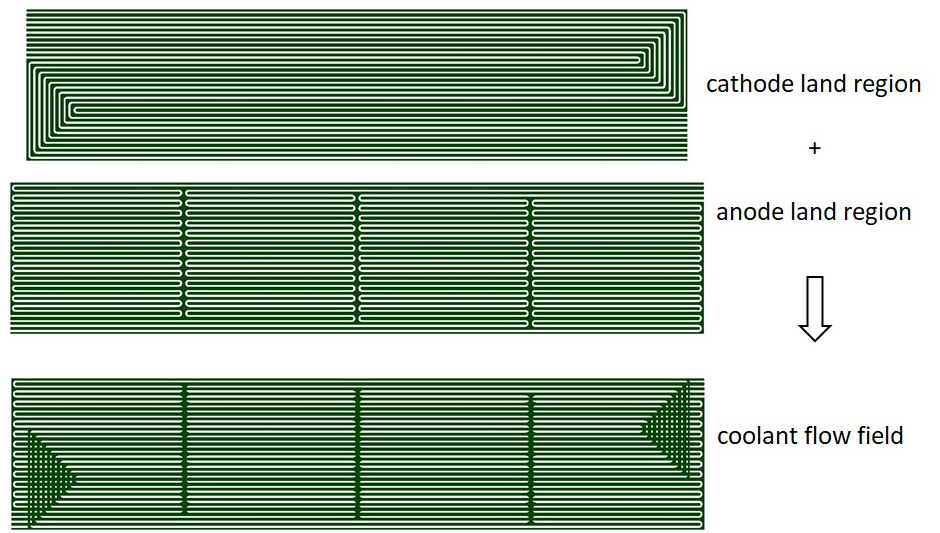
Figure 14. The resulting coolant flow field by combination of the land area of cathode and anode